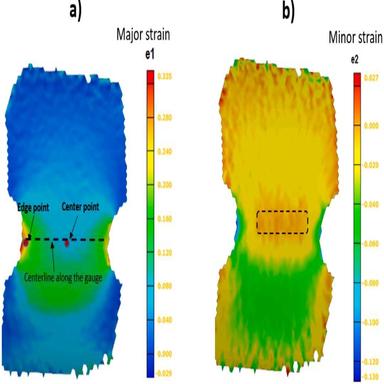
Full-field strain measurement using 3D-DIC system of the RHPST: (a) true major strain; (b) true minor strain.